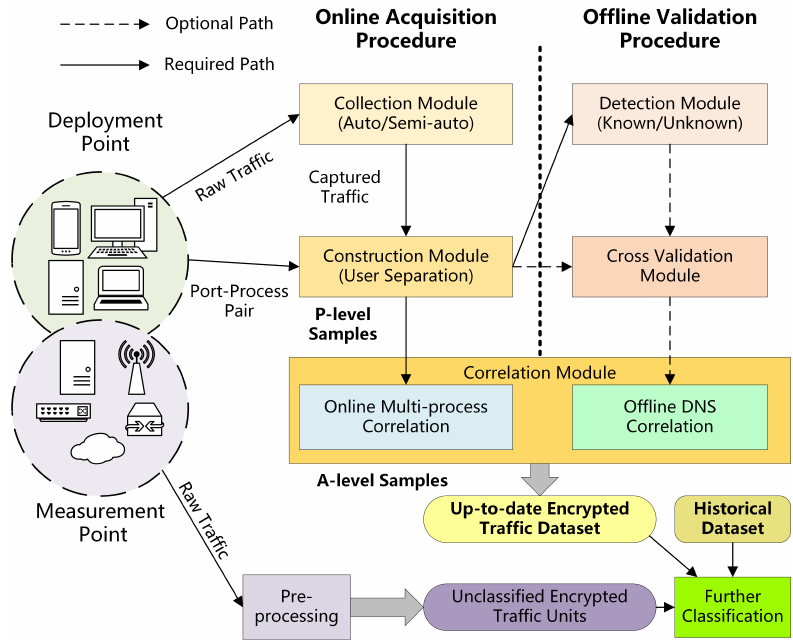
Figure 3. A3C system